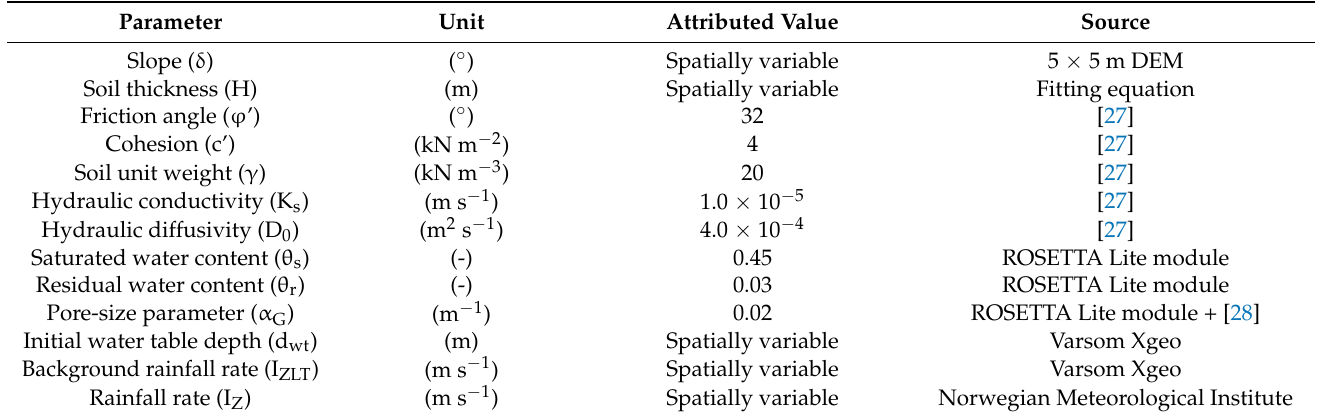
Table 1. Input parameters for the TRIGRS model.